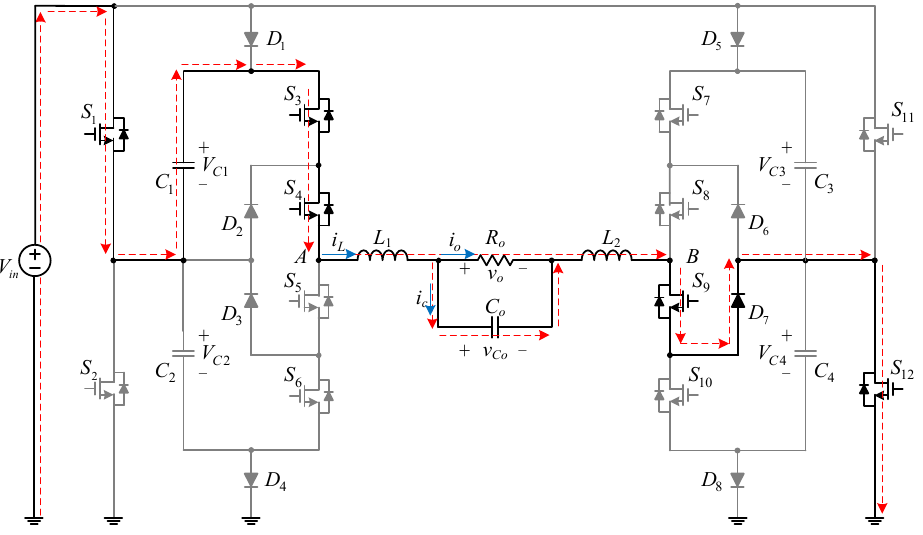
Figure 11. Current flow direction of stage III when the switch S 10 is on. Interval